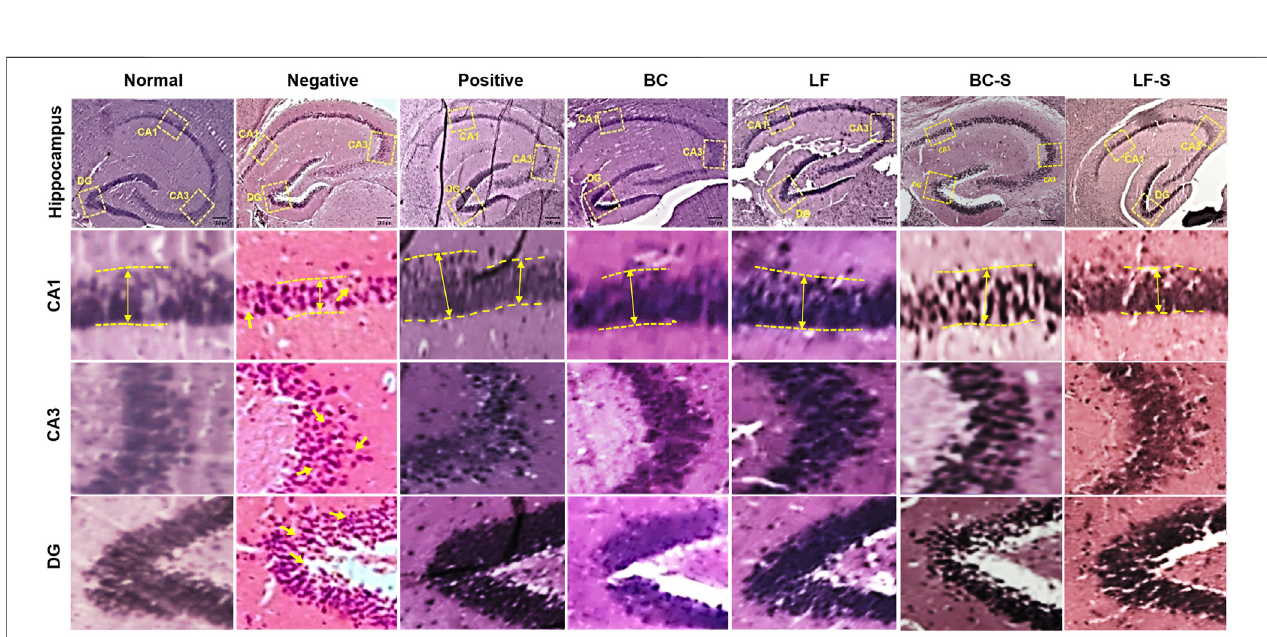
FIGURE4| Effectsof Lactobacillus fermentum NMCC-14 (10 10 CFU/day, p.o) and Bacillus clausii (10 10 CFU/day, p.o) onthe hippocampus CA1, CA3,and DGof subacuterestraint-stressedandnormalmice. Lactobacillusfermentum NMCC-14(10 10 CFU/day,p.o)and Bacillusclausii (10 10 CFU/day,p.o)improvedstress-induced neurodegenerative changes in the hippocampus CA1, CA3, and DG regions (H&E staining; magni fi cation ×10, scale bar: 200 µm).